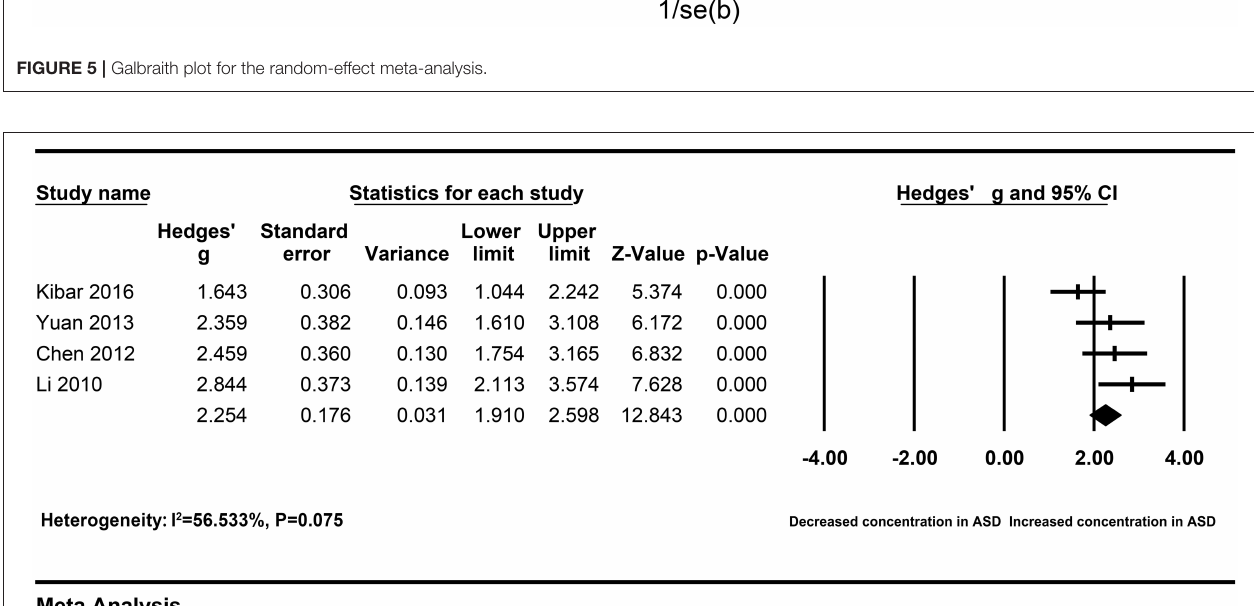
FIGURE 6 | Forest plot for the fixed-effect meta-analysis after removing the studies outside the boundaries of the Galbraith